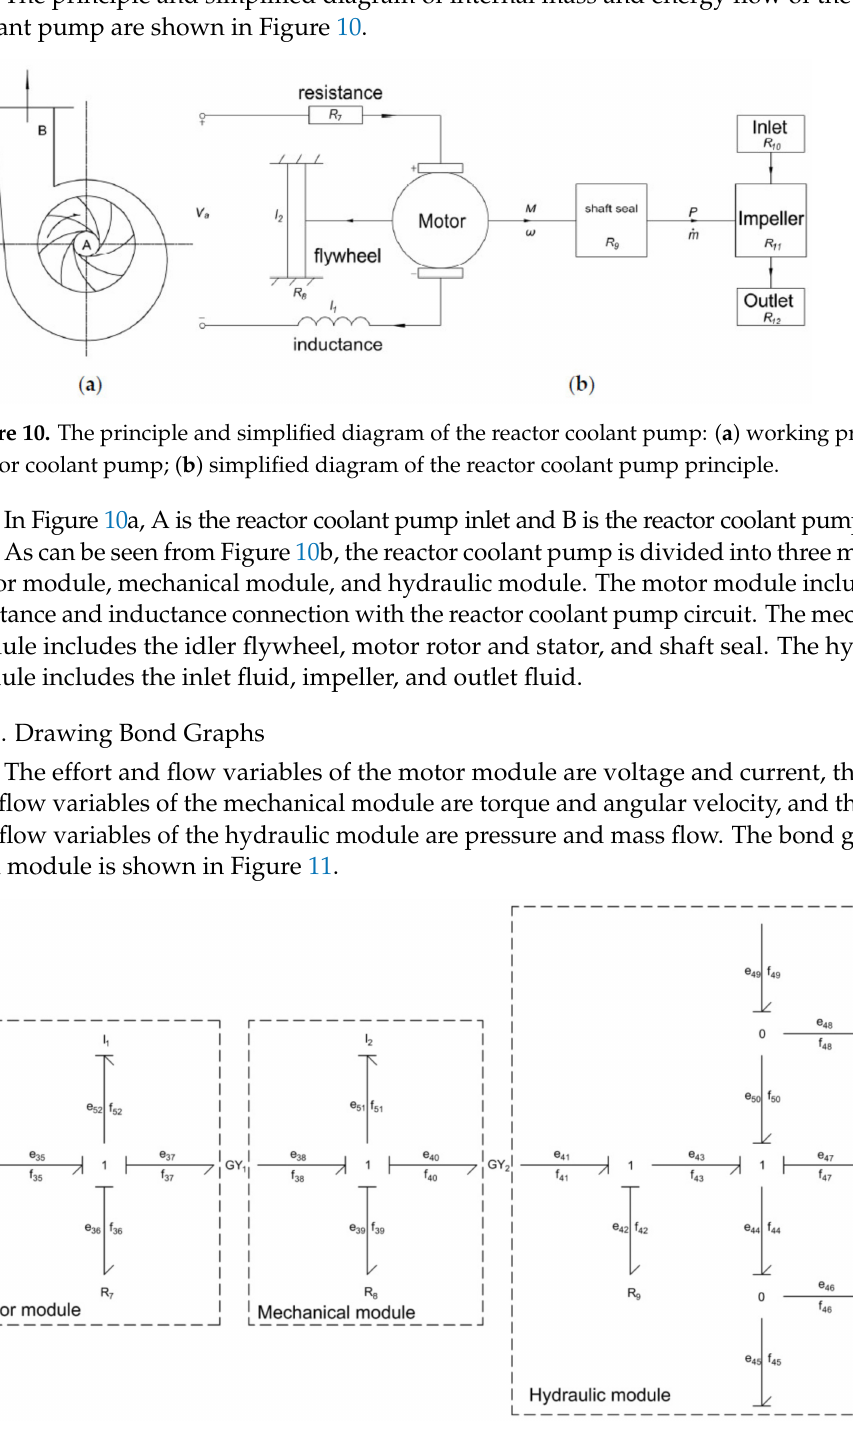
Figure 11. Bond graph model of the reactor coolant